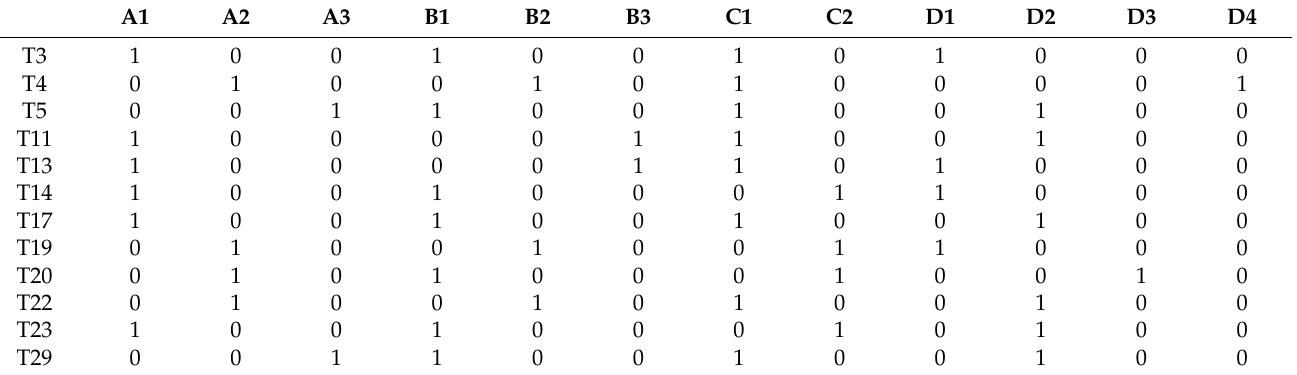
Table 8. Response matrix of design elements for quantitative class I